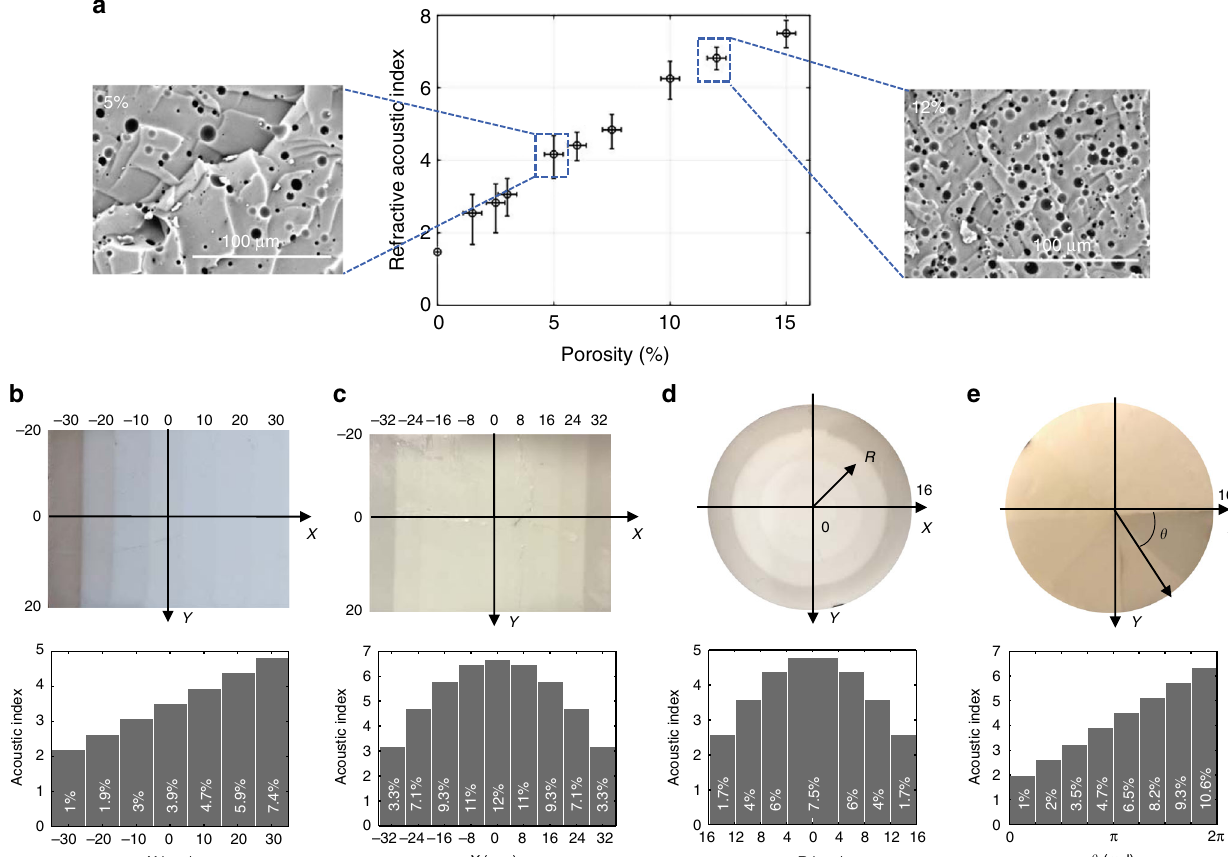
Fig. 1 Soft gradient-index metasurfaces with highly controlled gradients of porosity. a Measured relative refractive acoustic index n for various soft porous silicone rubbers with porosities ranging from 0% to 15%. Insets: Scanning electron microscopy images of the porous structure for Φ = 5% and 12%; These soft porous materials are fabricated with a targeted porosity controlled with an accuracy of 1%. b – e Examples of soft porous GRIN metasurfaces made of soft porous silicone rubber stripes with a thickness d = 2 mm. The corresponding acoustic index pro fi les are shown in the histograms below. The values mentioned at the bottom of the histograms correspond to the porosity in each porous stripe. The linear index pro fi le shown in b is designed for beam de fl ection with an angle of 5°, while the hyperbolic index pro fi le shown in c is designed for beam focusing with a focal length F = 70 mm. The radial index pro fi le shown in d is designed for 3D sound focusing with a focal length F = 20 mm, while the azimuthal index pro fi le shown in e is designed for the generation of an acoustic vortex beam with a topological charge l = +